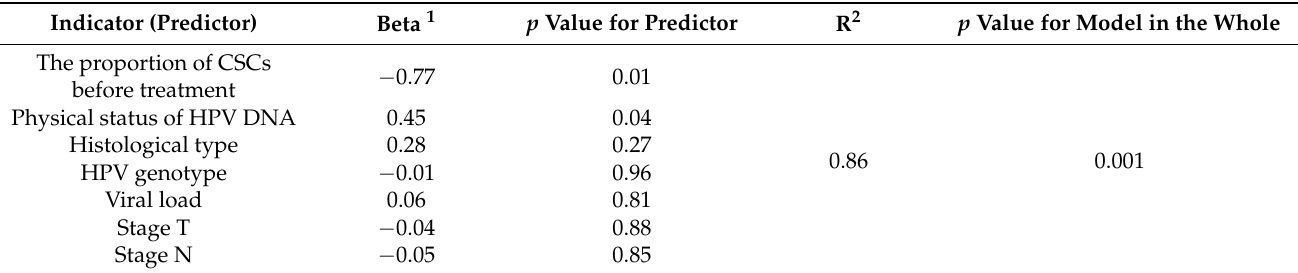
Figure 6. Correlation of the CSC proportion in cervical scrapings from CC patients before the treatment with change in this indicator after irradiation at a TD of 10 Gy. Dotted lines indicate 95% confidence limits for linear regression (solid line). Table 3. The results of multiple regression analysis of dependence of the changes in the CSC proportion after irradiation on possible